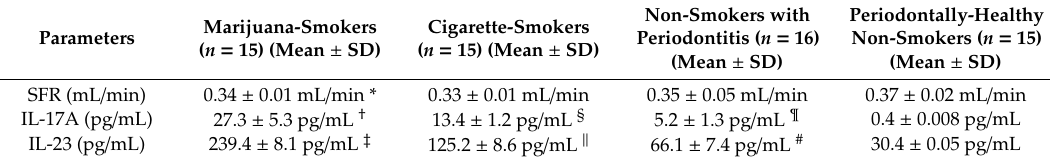
Table 3. Whole salivary flow rate and IL-17A and IL-23